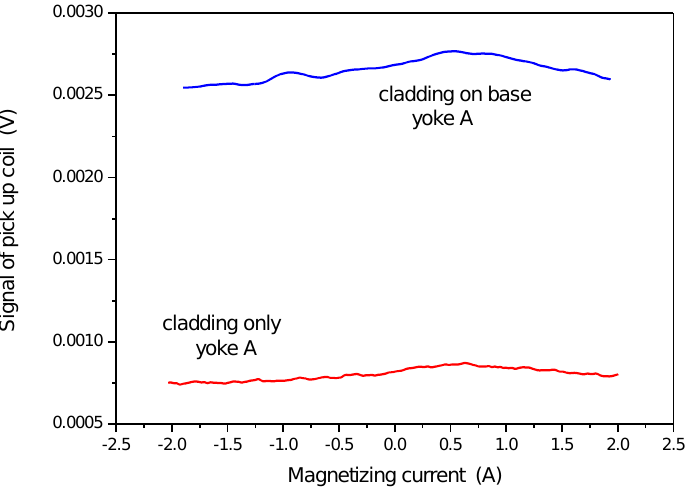
Figure 11. Signal of the pick-up coil as a function of the magnetizing current, measured on the pure cladding and on the cladding above the base material by applying Yoke A.